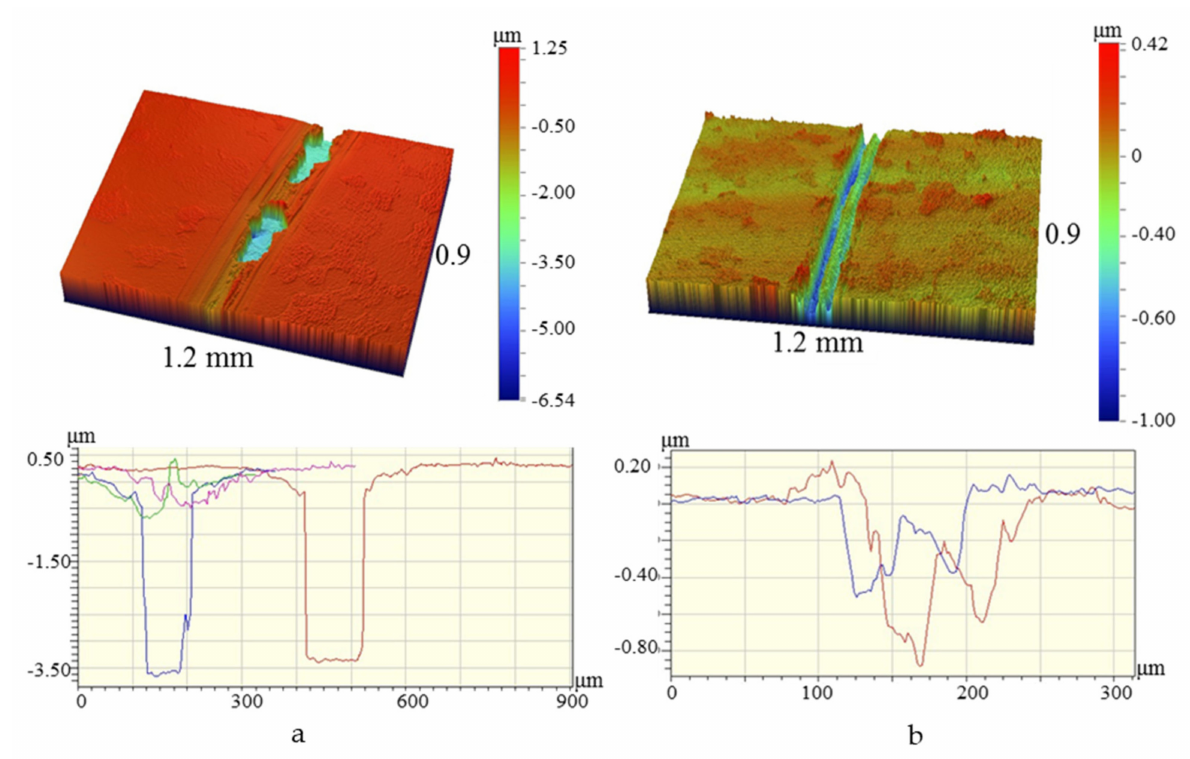
Figure 7. 3D and 2D profiles of the wear tracks for coatings 1 (100%Ar) ( a ) and 2 (85%Ar + 15%N 2 ) ( b ).